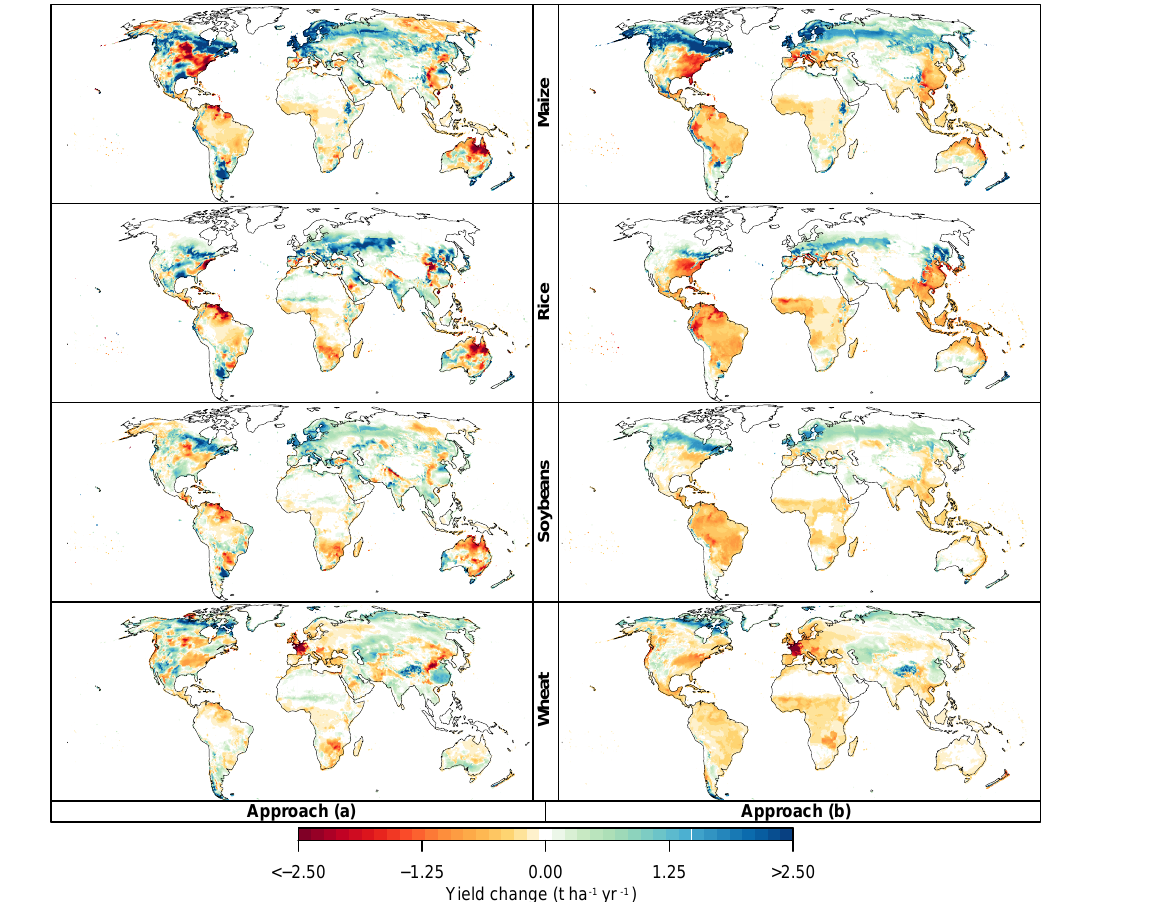
Figure 6. Climate-change-induced yield changes at (cid:49) GMT = 2.5 ◦ C of global warming and the year-2000 p CO 2 level (370ppm). Left column panels: patterns of (cid:49)Y clim ( i ) derived at each grid point i using approach (a) (see Eq. 1). Right column panels: corresponding patterns of (cid:49)Y clim ( i ), derived using approach (b) (see Eq. 3). Both types of patterns are derived from LPJmL simulations forced by HadGEM2-ES assuming rain-fed conditions and expressed as absolute differences compared to the historical period (1980–2010). Rows: different crop types. Analogous figures for irrigated conditions, for different GGCMs, and using relative instead of absolute yield changes are available in the